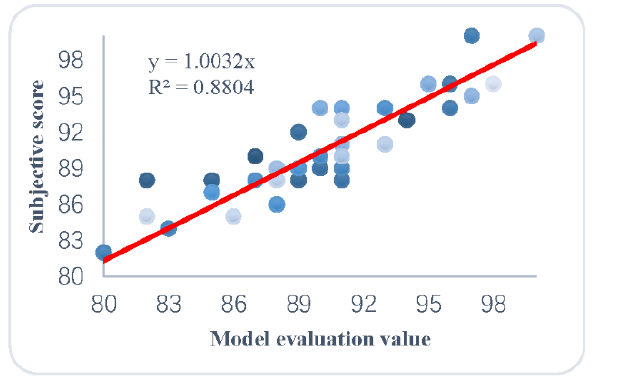
Fig. 7 Evaluation correlation analysis of safety